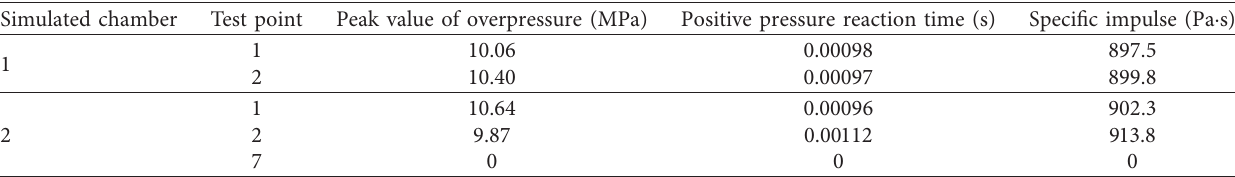
Table 1: Shock wave load